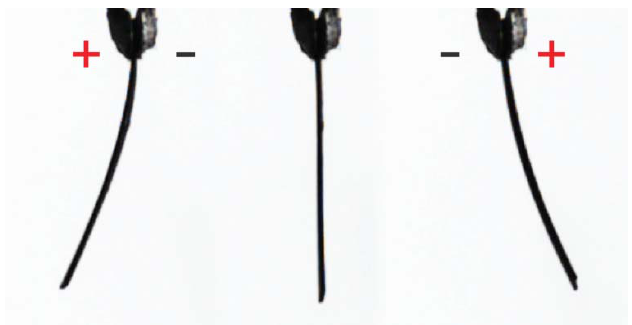
Figure 1. CPC under electric stimulus, i.e. , the behavior of the CPC